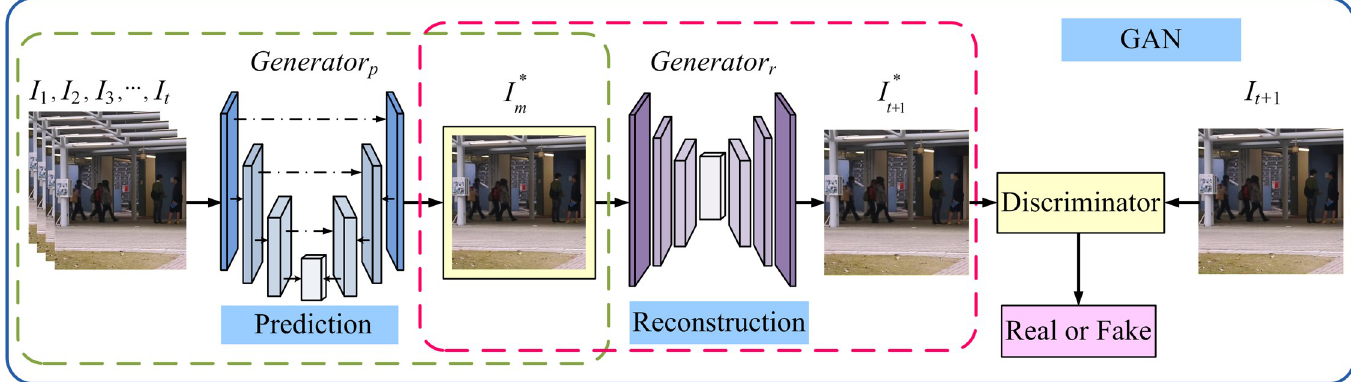
Fig 1. Overall framework of our method. The framework is mainly composed of prediction module, reconstruction module, and GAN module.